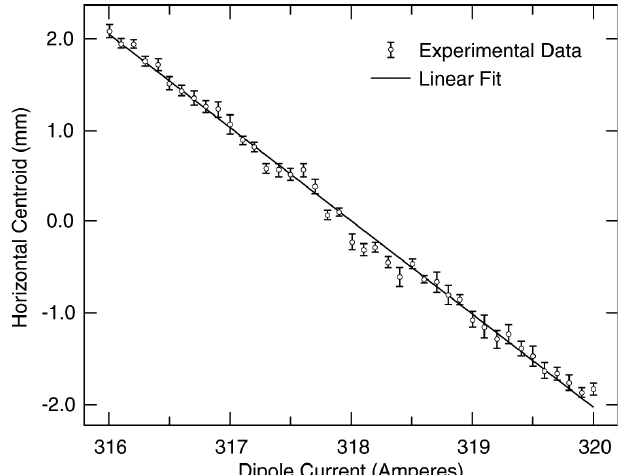
FIG. 8. Plot of the horizontal ODR image position (centroid) versus the upstream dipole magnet current supply value ( A ). The impact parameter is 0.75 mm for this case, and the Cherenkov detector indicated negligible beam losses.